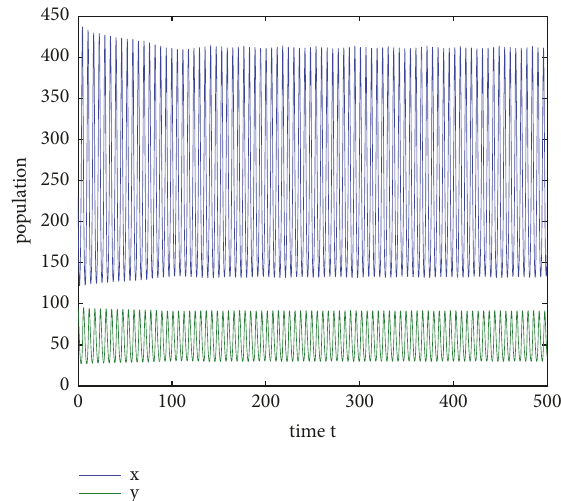
Figure 7: A Time series diagram for prey and predator. Existence of periodic solution around the interior equilibrium 𝐸 ∗ = (𝑥 ∗ ,𝑦 ∗ ) for themodel(2),wheretheparametervaluesare 𝑥(0) = 230 , 𝑦(0) = 95 , 𝐴 = 150 , 𝑟 = 2.65 , 𝐾 = 900 , 𝑎 = 0.02 , 𝑐 = 0.215 , and 𝑚 = 1.06 .